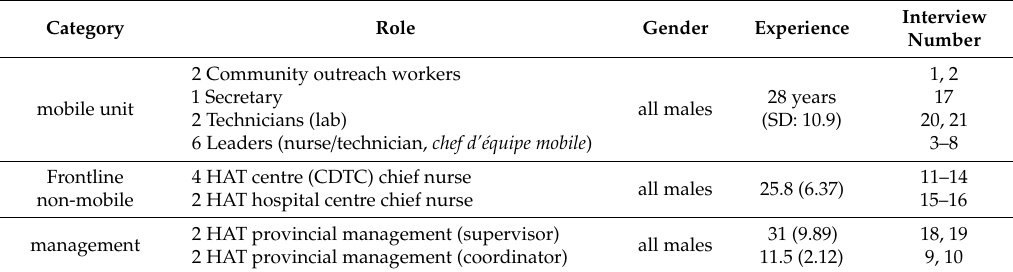
Table 1. Profiles of the research